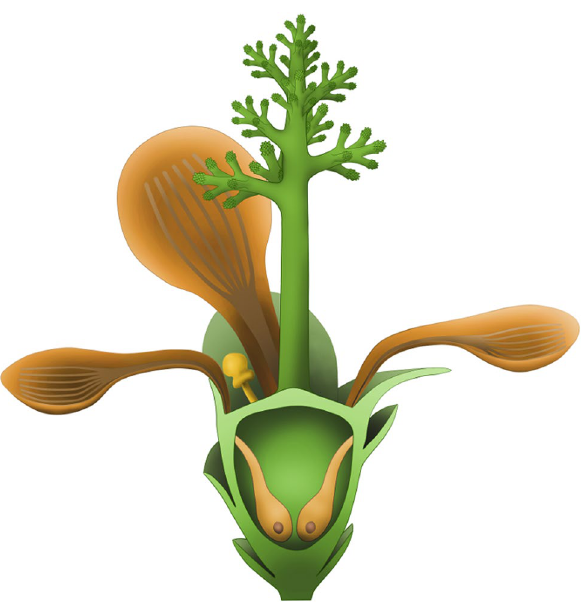
Figure 4. Updated reconstruction of Nanjinganthus dendrostyla . Note that the configuration of the ovule is slightly modified according to the new information revealed by